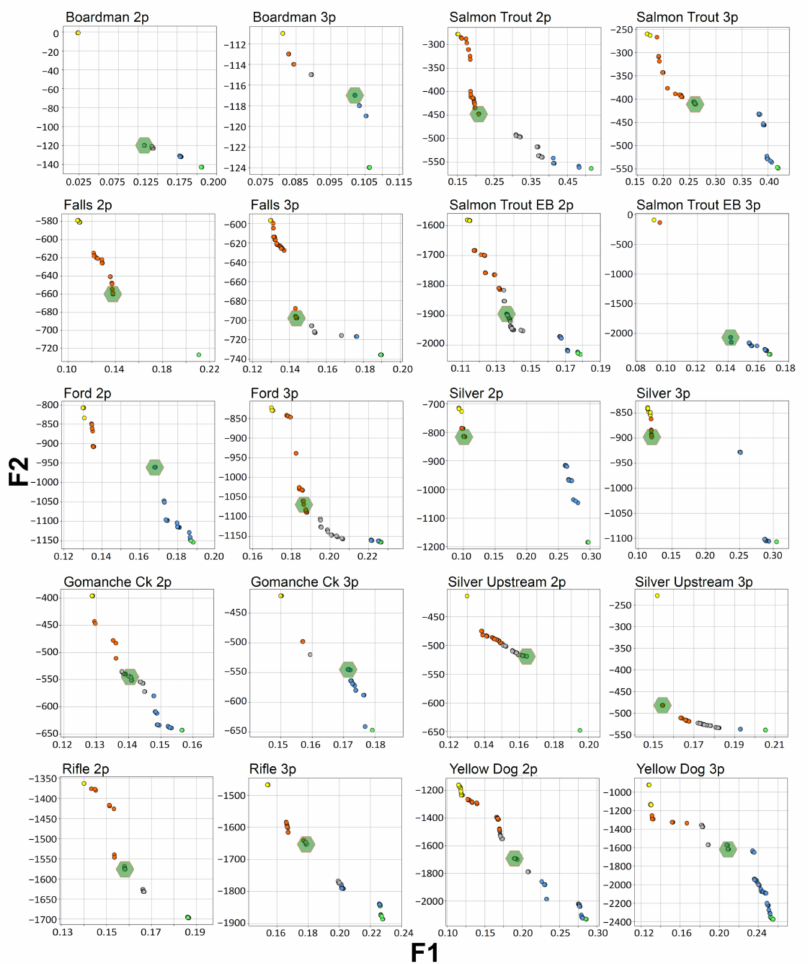
Figure 3. Pareto optimum fronts of the two-pass (2p) and three-pass (3p) MOO scenarios for all 10 stream gages. Selected trade-off solutions are highlighted in